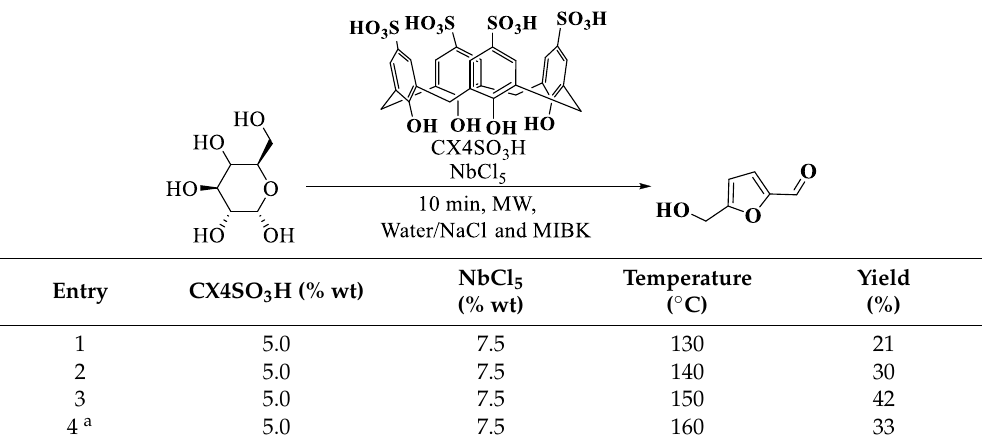
Table 2. Evaluation of reaction temperature.